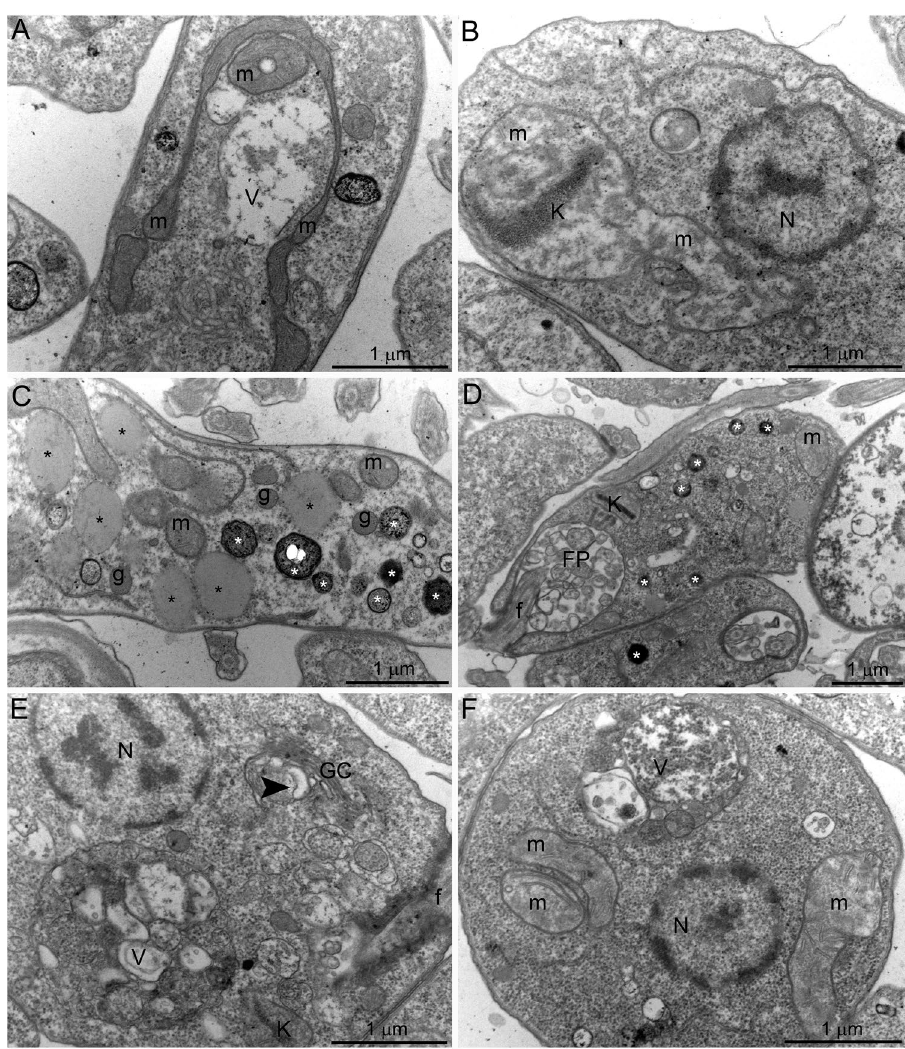
Figure 10. Ultrathin sections of Leishmania amazonensis promastigotes treated with 100 nM SBC 40 ( A – C ) or 300 nM SBC 40 ( D – F ) for 48 h. SBC40 also induced alterations in the parasite ultrastructure such as: mitochondrial swelling and structural disorganization ( A , B , F ); the presence of many lipid bodies electrondense and eletronlucent (stars, C , D ); a high number of extracellular vesicles inside flagellar pocket ( D ); the presence of several vacuoles similar to autophagosomes containing portions of the cytoplasm and membranes ( A , E , F ). Panel ( E ) shows a dilation at the trans-Golgi network. N nucleus, m mitochondrion, f flagellum, GC Golgi complex, k kinetoplast, asterisks lipid bodies, v autophagosome-like vacuole, g